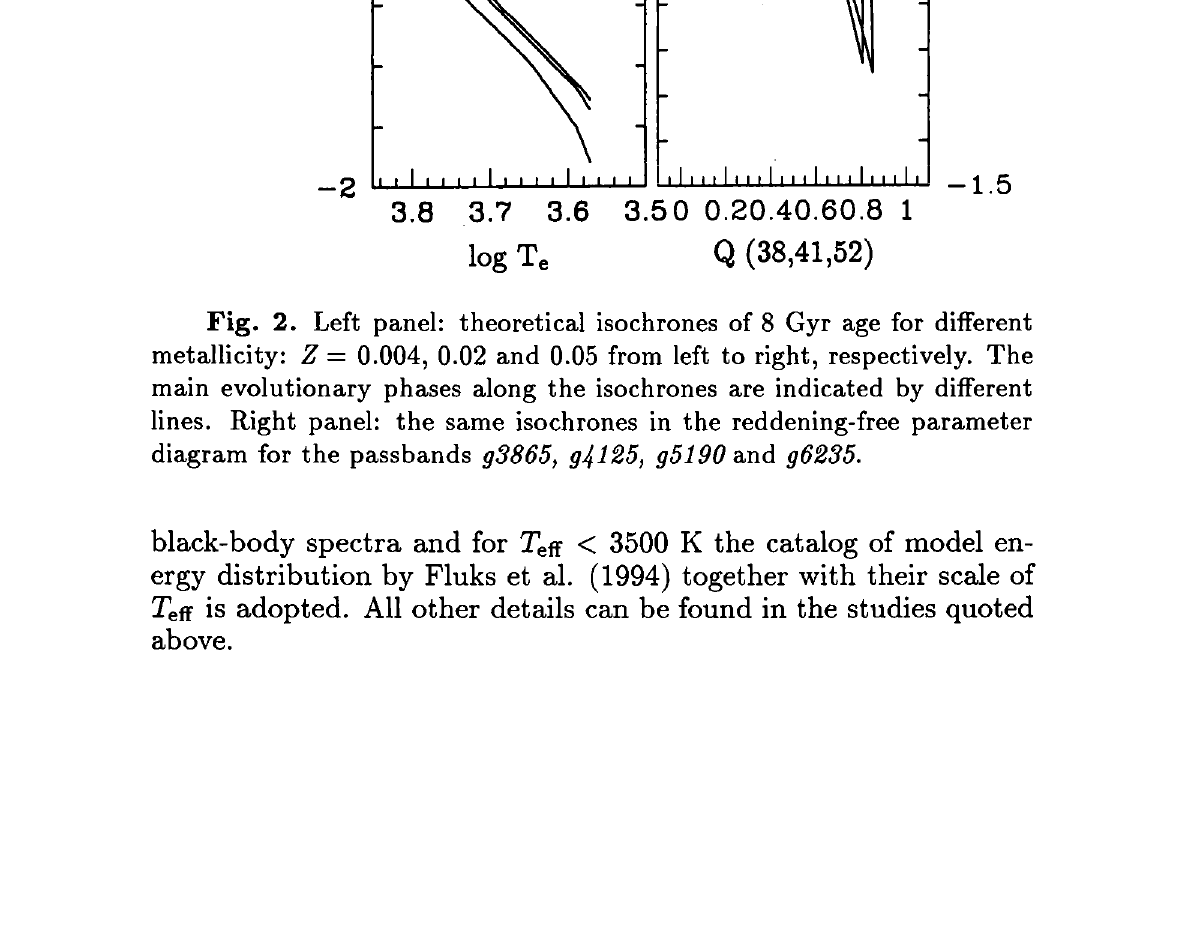
black-body spectra and for T e fr < 3500 Κ the catalog of model en- ergy distribution by Fluks et al. (1994) together with their scale of Teff is adopted. All other details can be found in the studies quoted